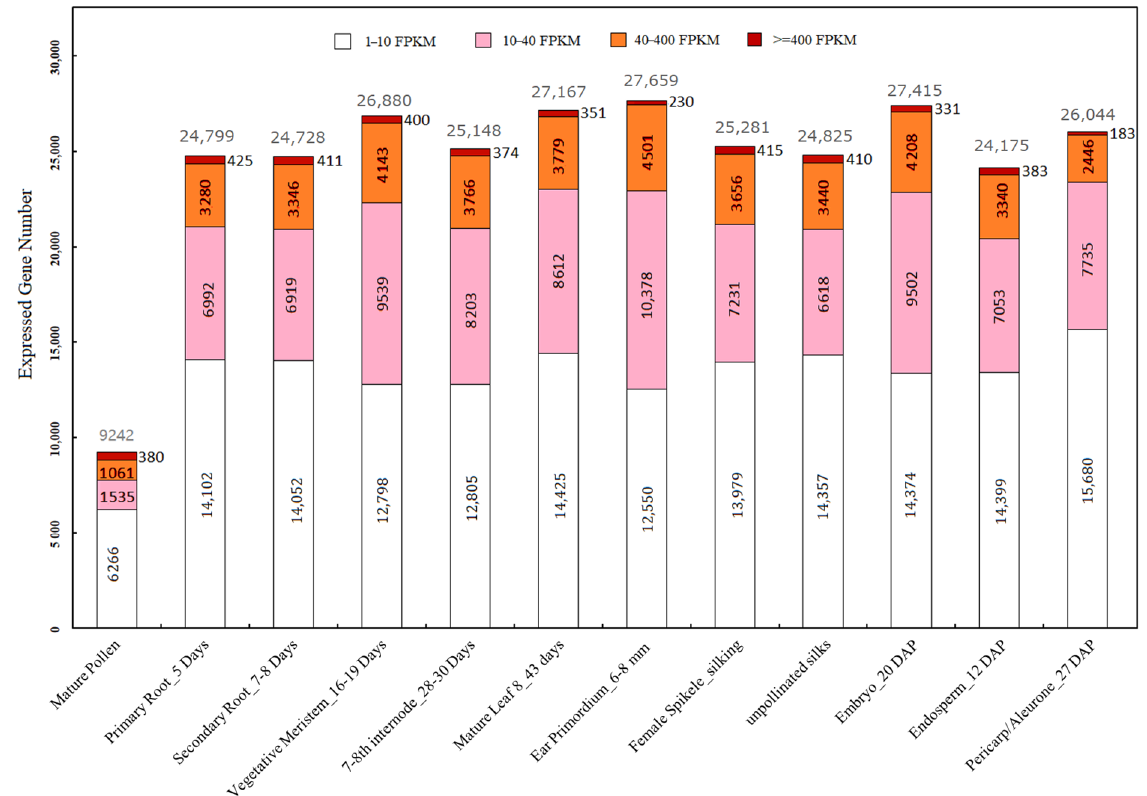
Figure 1. Unique transcripts identified in the 12 selected maize tissue types of this study grouped by levels according to their abundances. Very highly expressed genes (VHEG), highly expressed genes (HEG), medium expressed genes (MEG), and low expressed genes (LEG) are indicated in dark red, orange, pink, and white color, respectively. VHEG, HEG, MEG, and LEG possess the transcript levels of ≥400, 40–400, 10–40, and 1–10 FPKM, respectively. The total EG number of each tissue was indicated on the top of the columns in grey color. The transcript profiles of 12 tissues were extracted from the dataset of the B73 developmental atlas